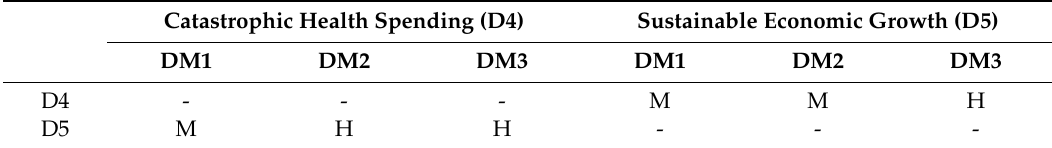
Table 4. Linguistic evaluations of decision makers for the financial-based perspective.